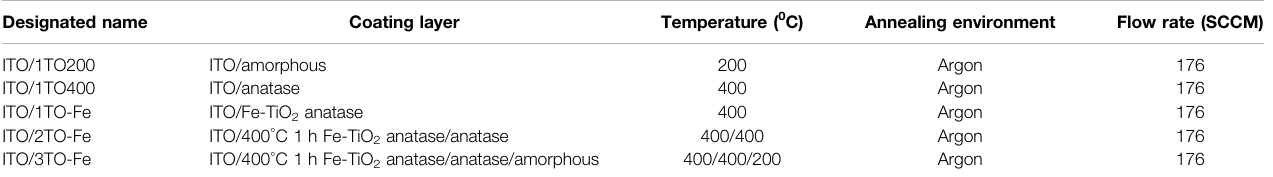
TABLE 3 | Annealing treatment conditions for doped and plain TiO 2 over ITO.